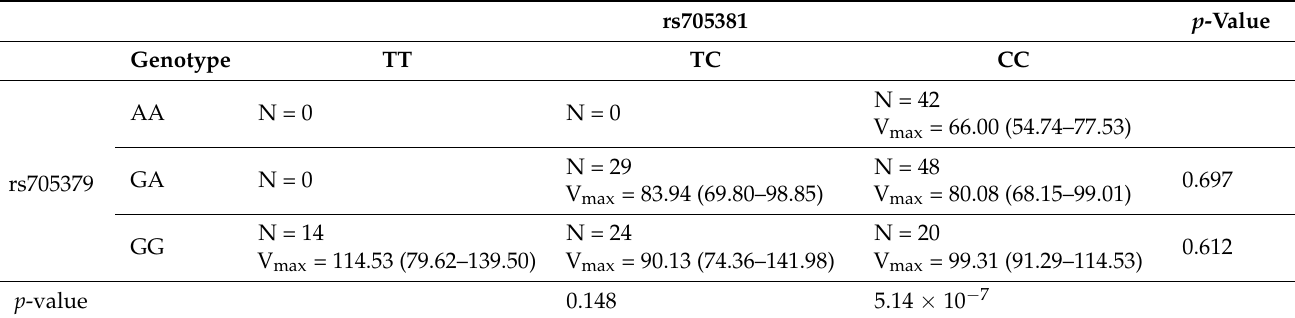
Table 3. Average V max values (in µ M/min) for each pair of genotypes of the PON1 SNPs rs705379 and rs705381. Some pairs of genotypes were not present in any patient in our study (N = 0). A cell shows the number (N) of patients with a certain pair of genotypes and the median (interquartile range) for V max